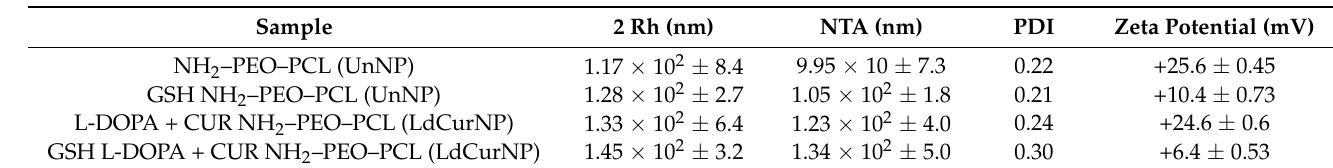
Table 1. Physicochemical parameters of NH 2 –PEO–PCL, GSH adsorbed and L-DOPA and curcumin- loaded nanoparticles in aqueous solution.